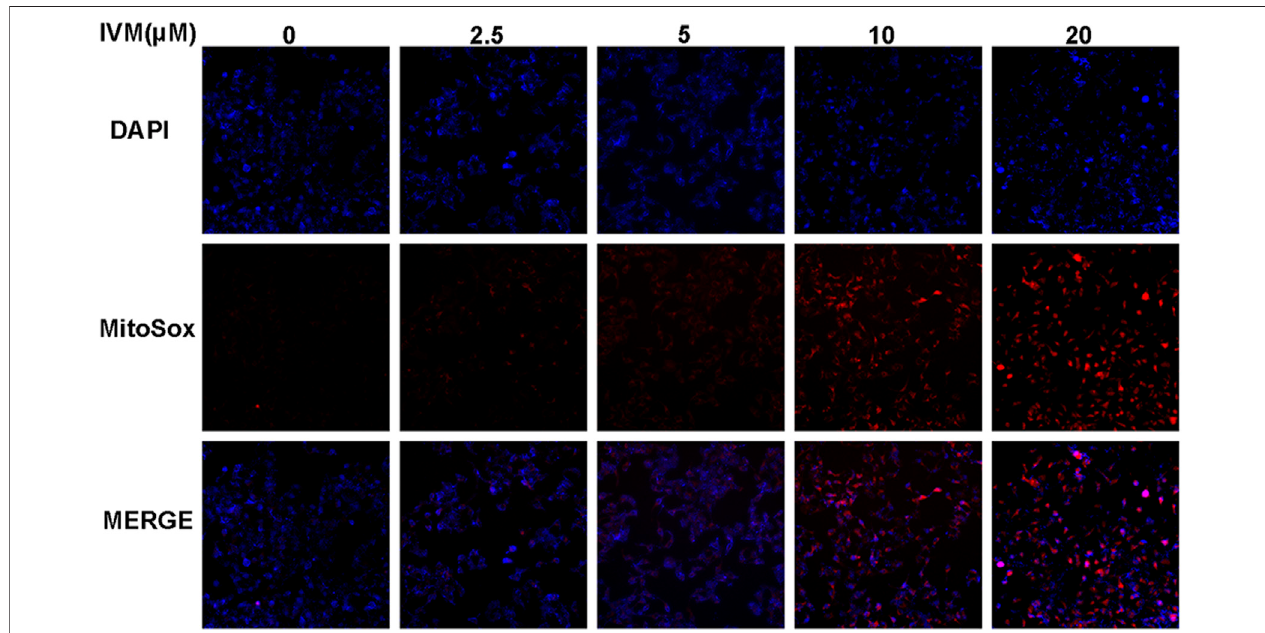
FIGURE 8 | Ivermectin increased mitochondrial ROS generation in SW1116 cells. SW1116 cells were treated with ivermectin at the indicated concentrations (0, 2.5, 5, 10, and 20 μ M) for 6 h. Then the cells were co-stained by MitoSOX and DAPI, described as the “ Materials and Methods ” section; cells were visualized using a fl uorescence microscope. Representative images were shown, and the experiment was repeated three times. IVM, ivermectin.